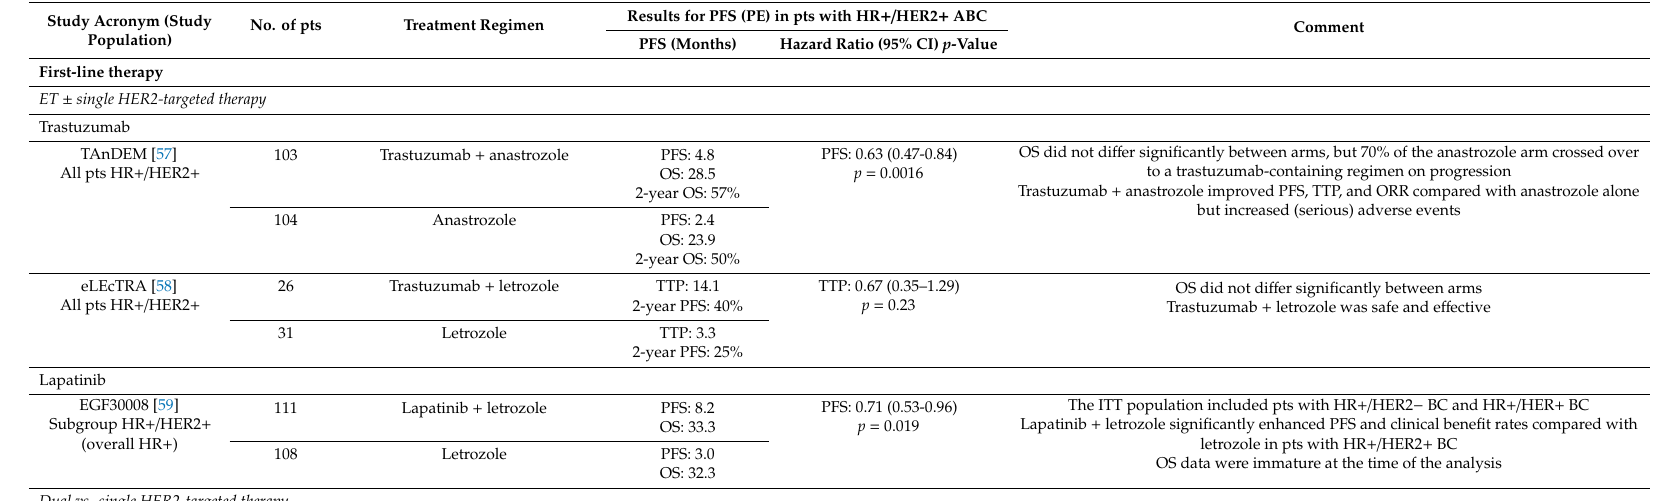
Figure 2. The evolution of human epidermal growth factor receptor 2 (HER2) blockade strategies in HER2+ breast cancer. CT = chemotherapy, EBC = early breast cancer, HER2 = human epidermal growth factor receptor 2, MBC = metastatic breast cancer, neo / adj = (neo) adjuvant, and TDM1 = trastuzumab emtansine. Table 1. Phase II and III trials in the metastatic setting evaluating the outcomes in patients with HR+/HER2+ breast cancer.